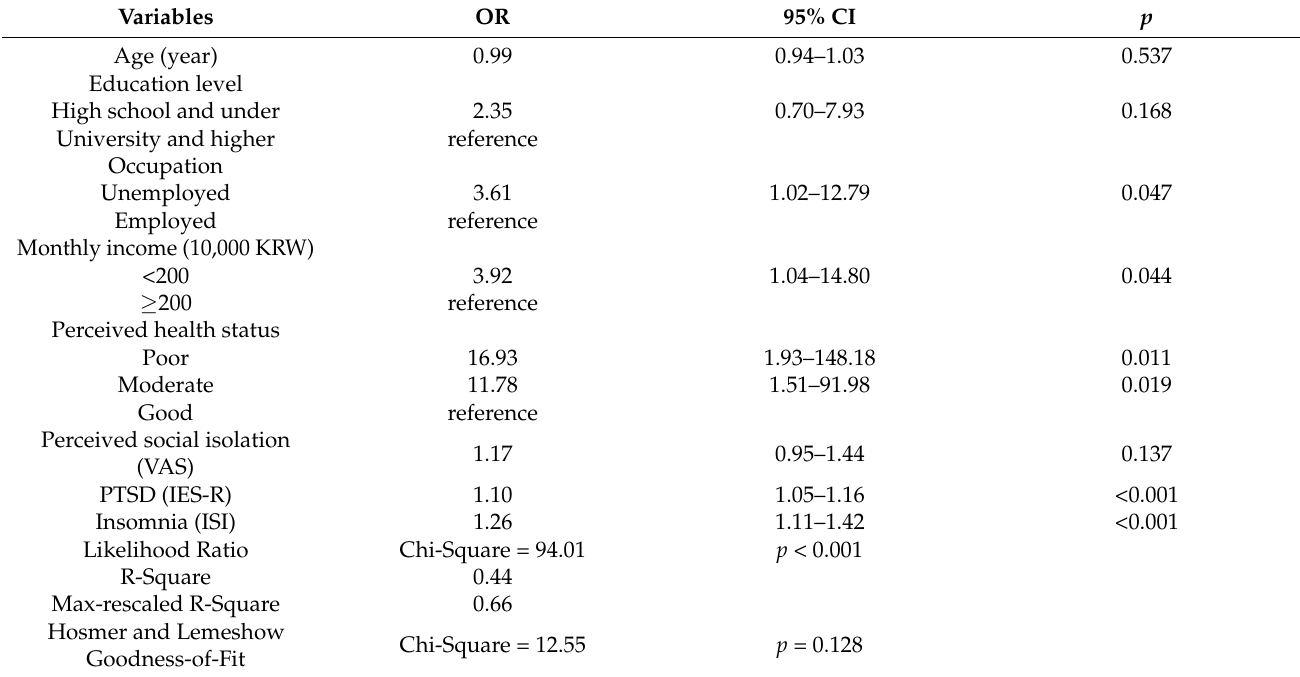
Table 3. Risk factors of depression by multivariate logistic